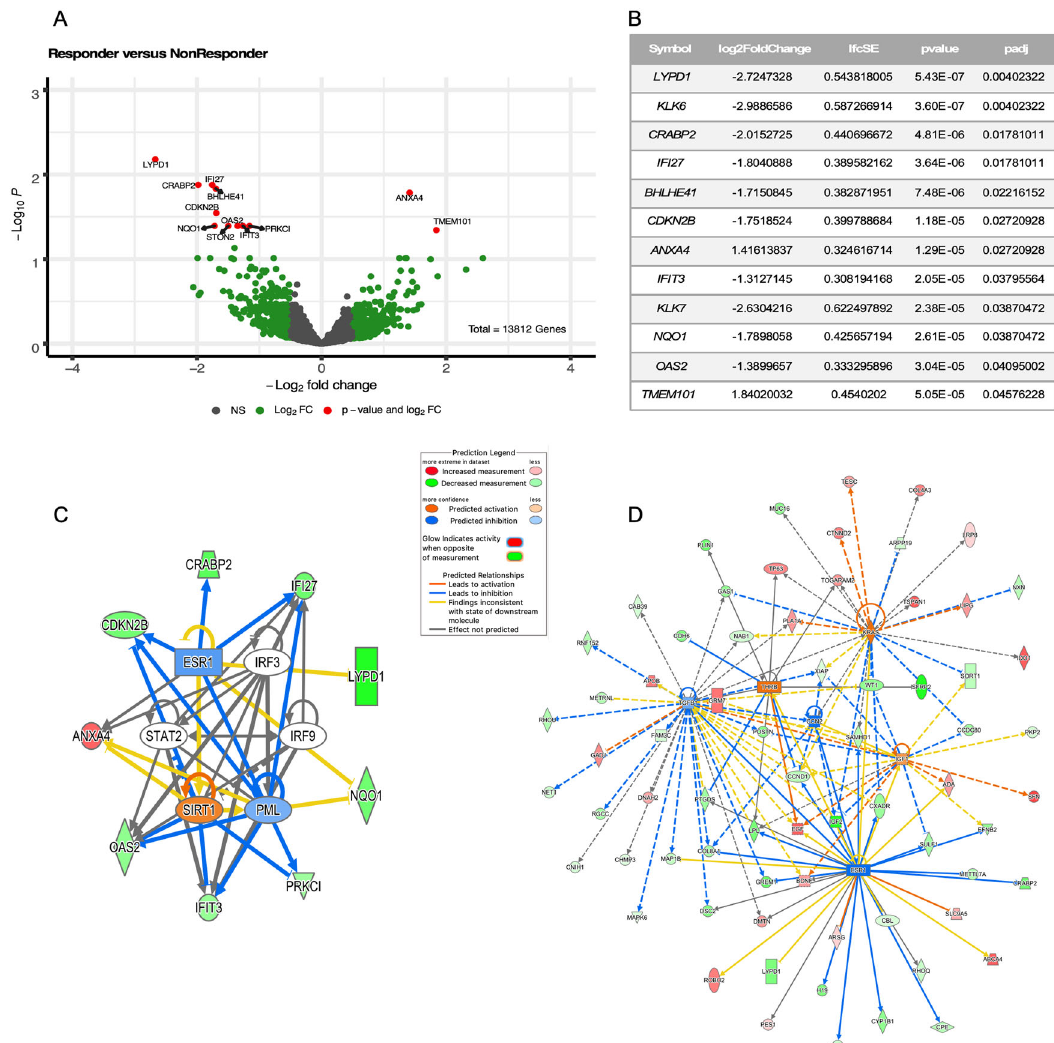
Fig. 2 Differential expression pro fi le in 49 gynecological cancer patients based on responses to immunotherapy. A Volcano plot of genome-wide differential expression analysis, with x -axis as -Log2 (Fold Change), y -axis as -Log10 (adjusted p value). Green dots highlighted genes with fold change ≥ 2, red dots highlighted genes with fold change equal or larger than 2, and adjusted p value ≤ 0.05, gray dots presented as genes were not signi fi cantly expressed between responders and non-responders. B The list of 12 signi fi cantly expressed genes between responders and non-responders, with corresponding log2(folder change), log2(folder change) standard error, p value attained by the Wald test, adjusted p value corrected for multiple testing using Benjamini and Hochberg method. C IPA network of top upstream regulators, based on the 12 signi fi cantly expressed genes among the entire cohort. D IPA network of 6 top common upstream regulators ( KRAS, ESR1, IGF1, CCN2, THRB , and TGFB1 ) derived from individual disease